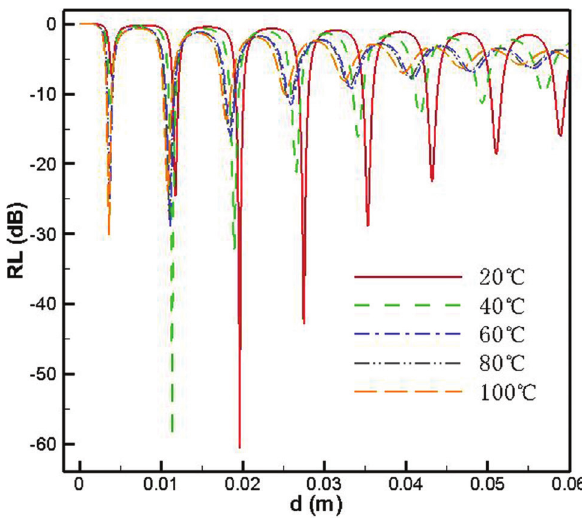
Fig. 4: Temperature dependence of RL of petroleum coke (10% moisture content) as the thickness varies from 0 to 0.06 m: